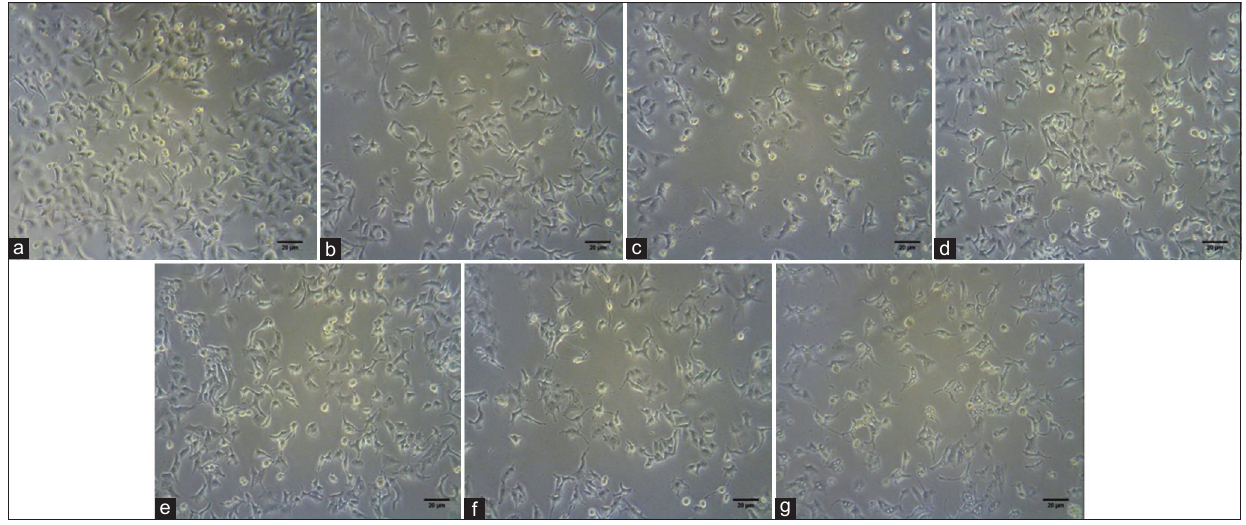
Figure-11: (a-g) A photomicrograph of the non-small cell lung cancer (NSCLC) (A549) cells’ viability. NSCLC (A549) cells were